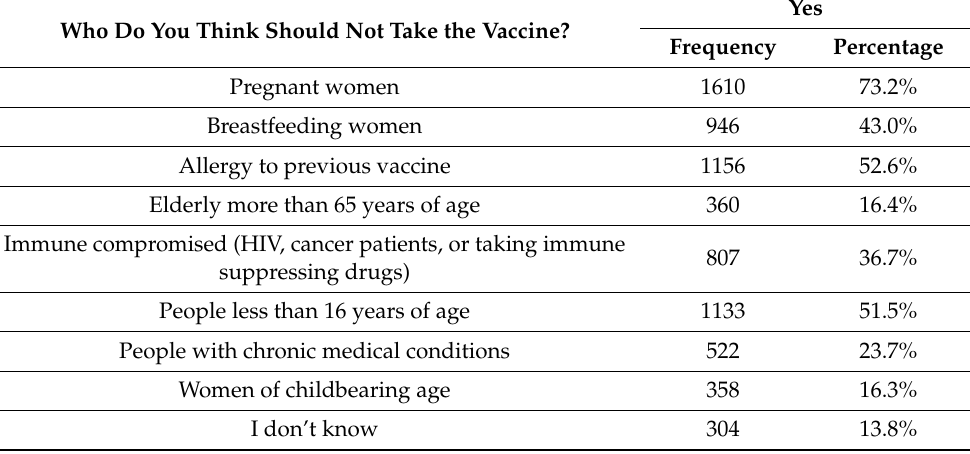
Table 3. The participants’ knowledge about who should not take the COVID-19 vaccine. Who Do You Think Should Not Take the